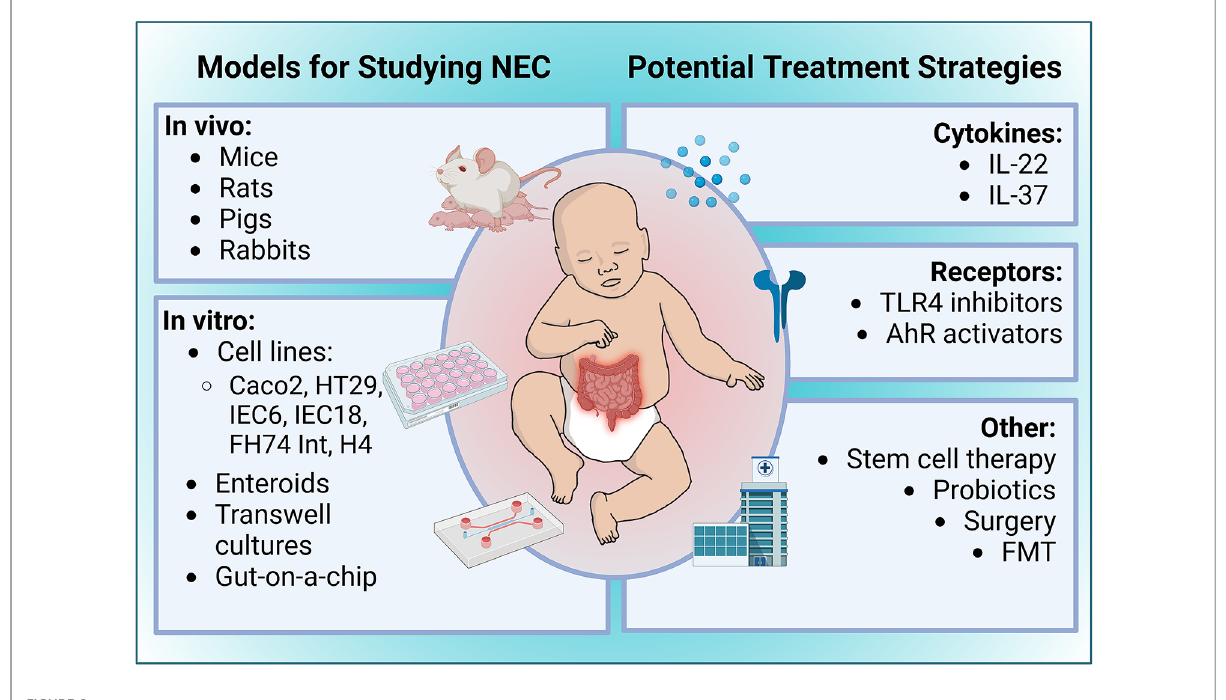
FIGURE 2 Overview of experimental models of NEC and potential treatment strategies. Figure created with